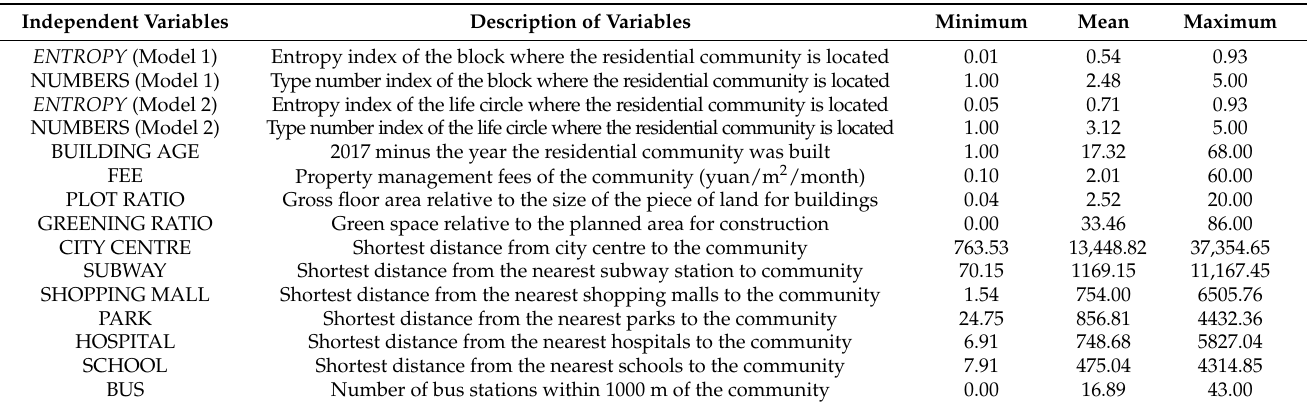
Table 2. Independent variables and descriptive statistics.